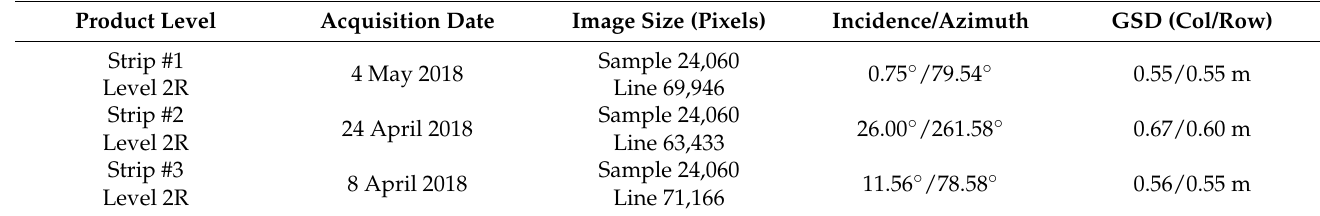
Table 1. Test data specification.